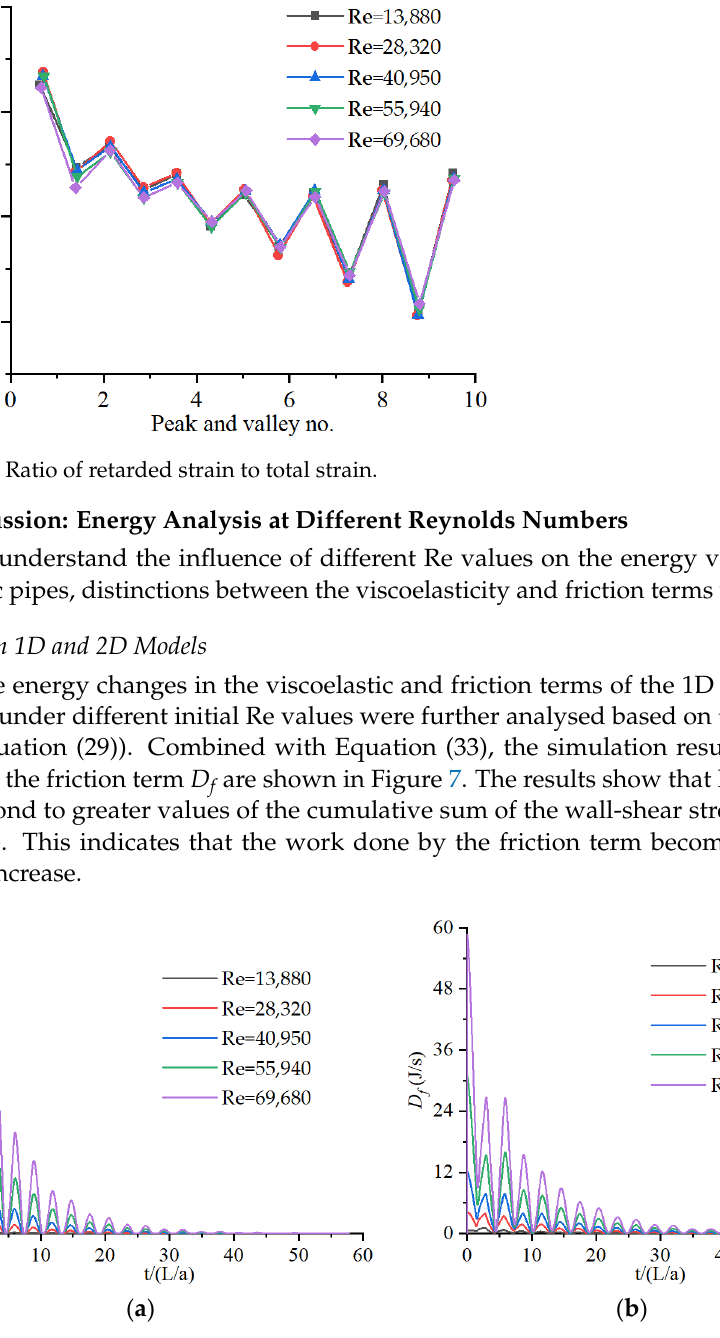
9 of 16 Figure 5. The time difference between the extreme value of retarded strain and instantaneous strain. To further illustrate the viscoelastic effect, the ratio of retarded strain to total strain ( 𝜀 𝑟 /𝜀 ) is shown in Figure 6. As can be seen in the line graph, the ratio at the valley de-